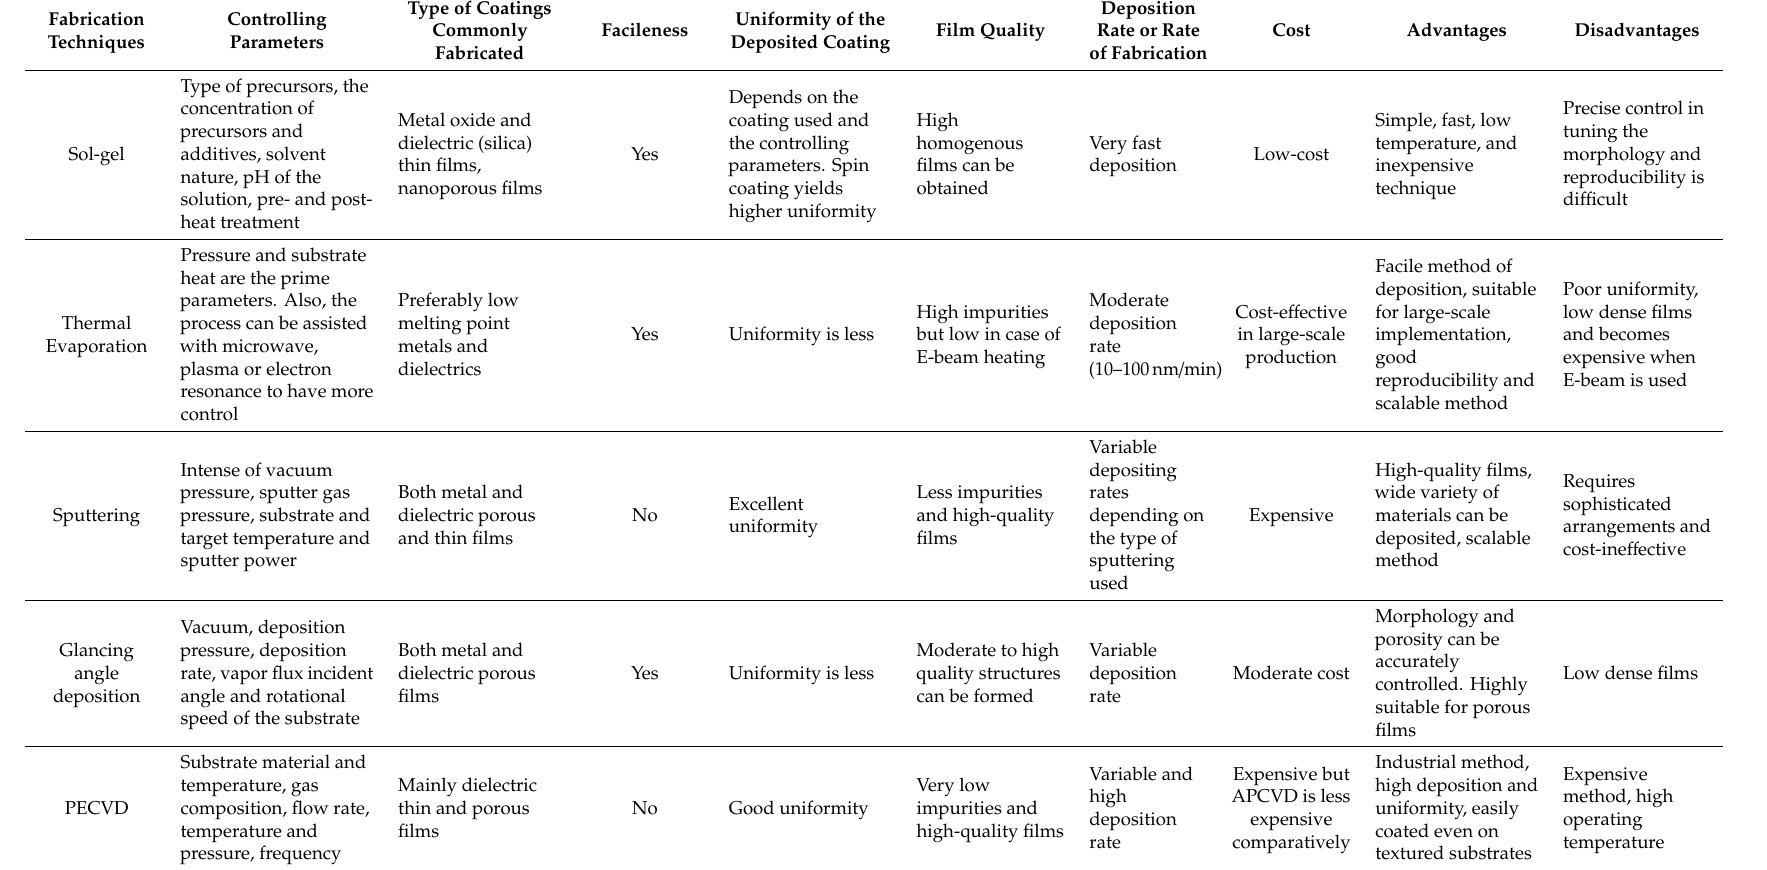
Table 2. Comparison of various fabrication technologies commonly used for antireflection